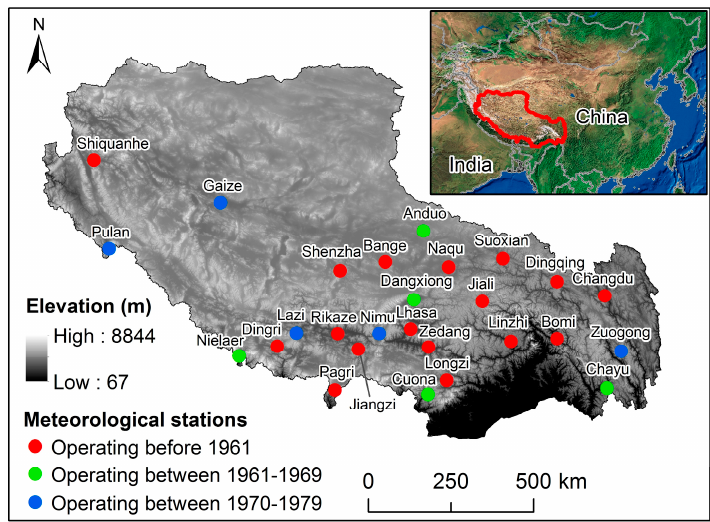
Figure 1. Spatial distribution of the meteorological stations over the mid-south of Tibetan Plateau considered in this study. The stations that are valid during 1961–2017, 1970–2017 and 1980–2017 are denoted by red, green and blue circles, respectively.